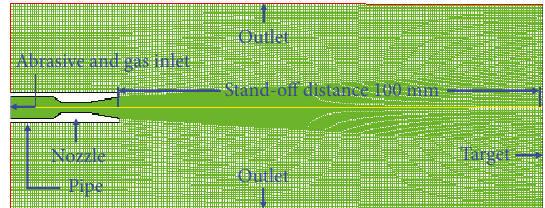
Figure 3: Geometrical model of numerical simulation.